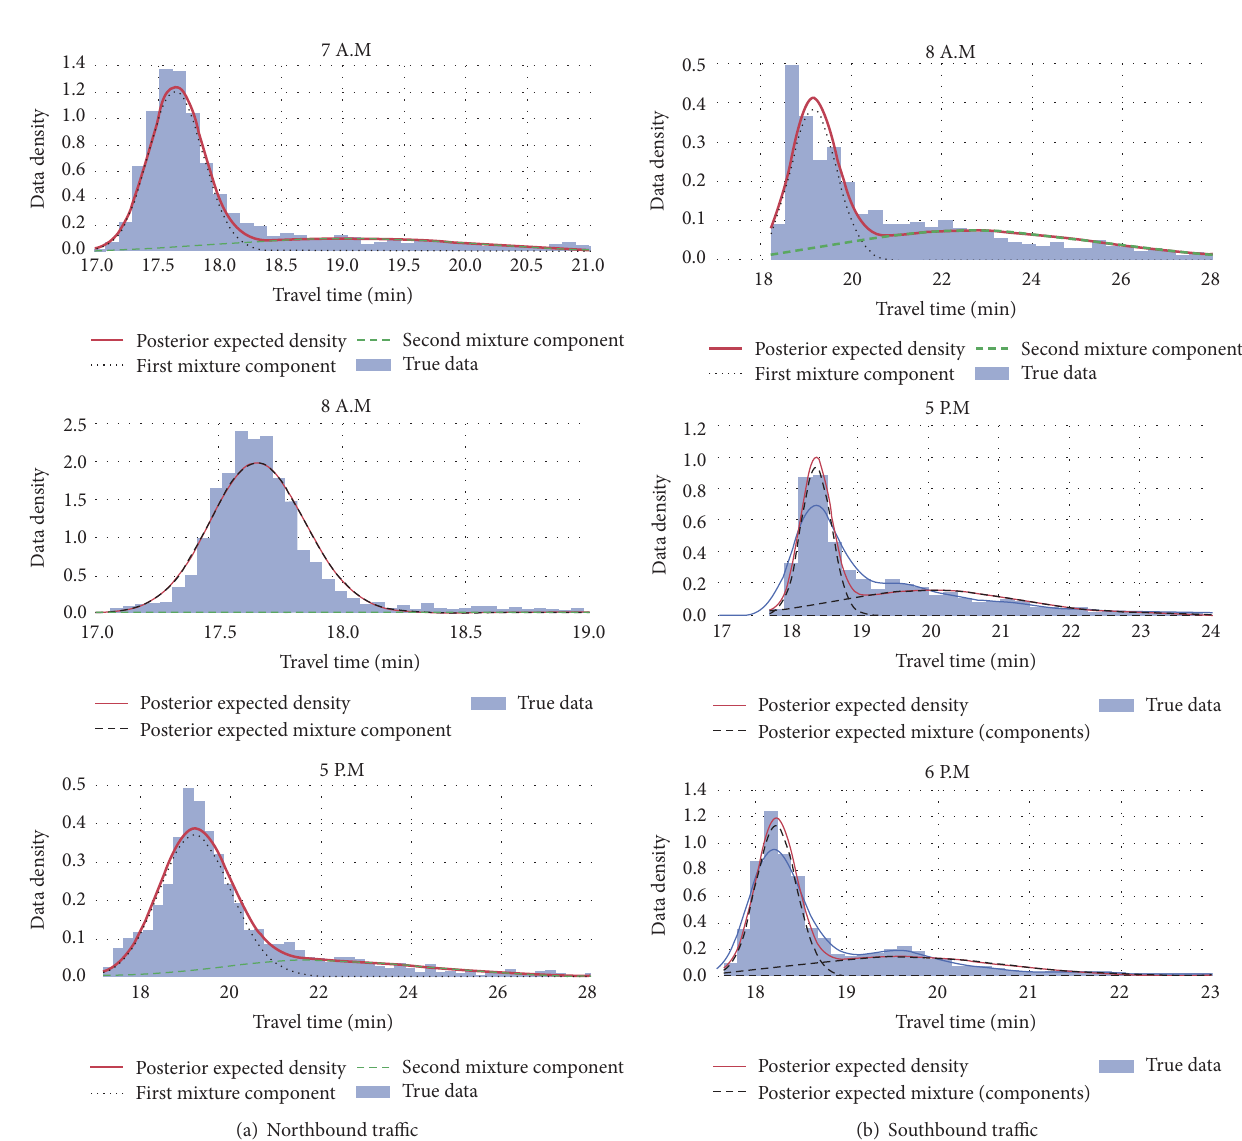
Figure 3: Time of the day corridor travel times.